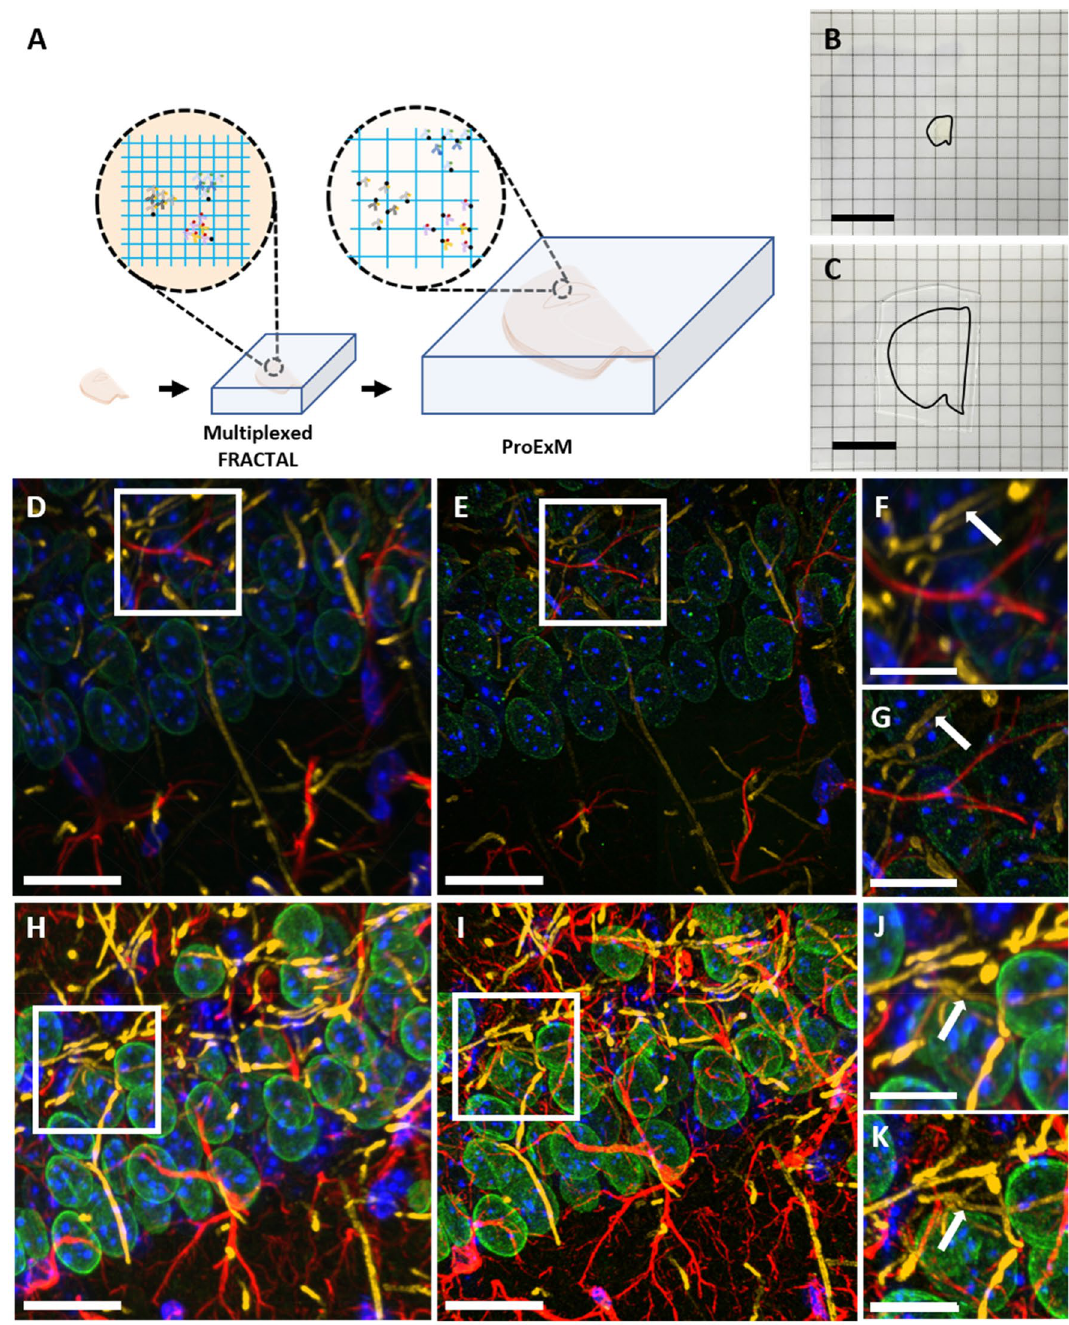
Figure 5. ExM imaging of a multiplexed FRACTAL sample. ( A ) Schematic of multiplexed FRACTAL and ProExM. ( B ) Photograph of a half brain slice before expansion. ( C ) Photograph of the same half brain slice shown in B after expansion. ( D – K ) Confocal images of pre-expansion and post-expansion mouse brain samples before and after signal amplification via multiplexed FRACTAL. ( D – G ) Before signal amplification: ( D ) Pre- expansion. ( E ) Post-expansion, with expansion factor of 3.30. ( F ) Enlarged image of brain region highlighted in ( D ). ( G ) Enlarged image of highlighted region in ( E ). ( H – K ) After six rounds of signal amplification: ( H ) Pre-expansion. ( I ) Post-expansion with expansion factor of 3.16. ( J ) Enlarged image of highlighted region in ( H ). ( K ) Enlarged image of highlighted region in ( I ). ( D ) and ( H ) were obtained under the same acquisition conditions. ( E ) and ( I ) were obtained under the same acquisition conditions. For ( B ) and ( C ), the scale bar is 1.5 cm. For ( D ), ( E ), ( H ), and ( I ), the scale bar is 20 µ m. For ( F , G , J ), and ( K ), the scale bar is 10 µ